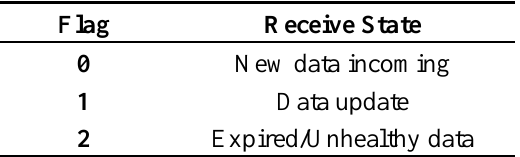
Table 2. The state of the SIS ephemeris